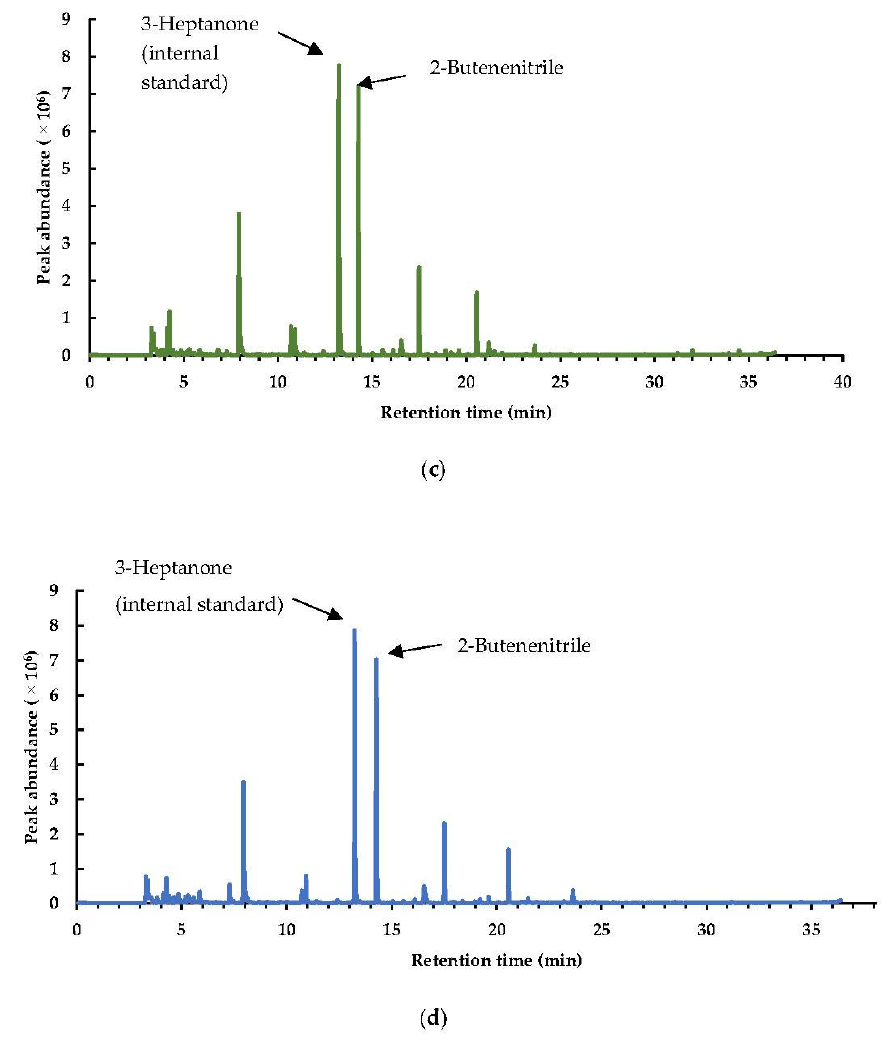
Figure A1. Representative total ion chromatograms of volatile compounds present in the volatile profile of differently pretreated Brussels sprouts. ( a ) NoPT; ( b ) Mix + Heat; ( c ) PEF + Heat + Mix; ( d ) Heat + Mix. The identities of the volatiles with the highest abundance are indicated on each chromatogram.